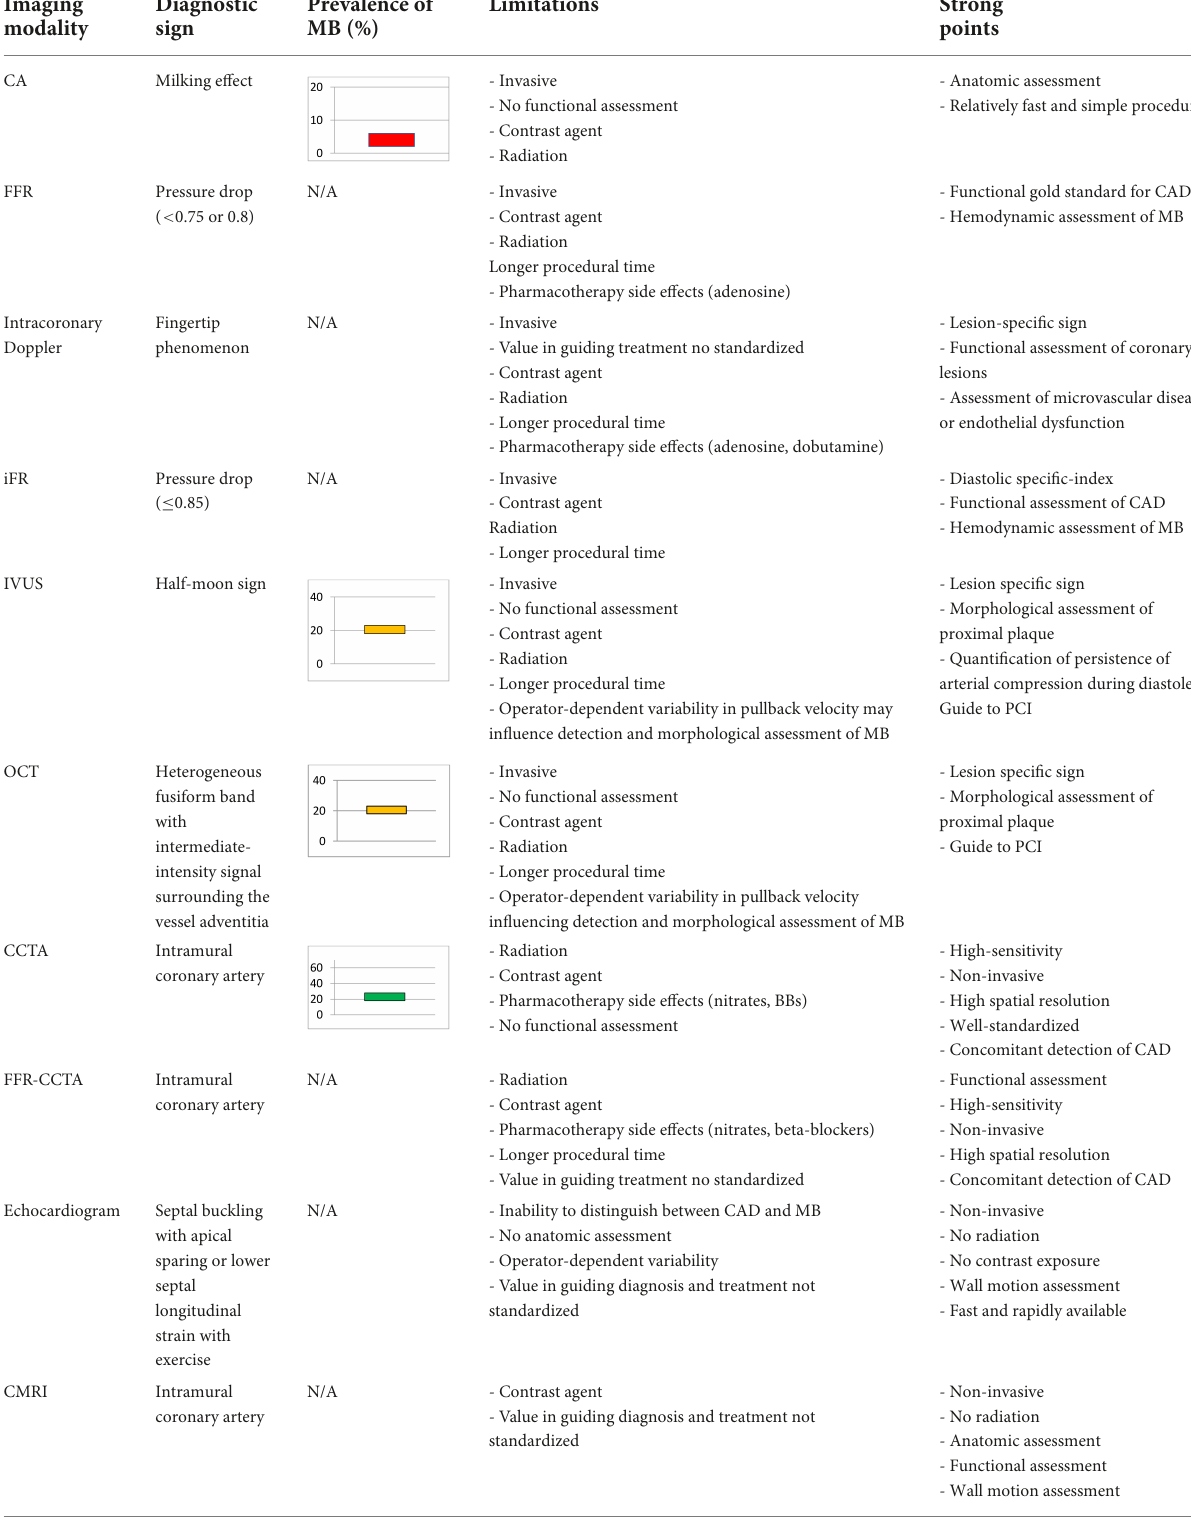
TABLE 1 Invasive and non-invasive diagnostic modalities for the detection, anatomic and functional assessment of